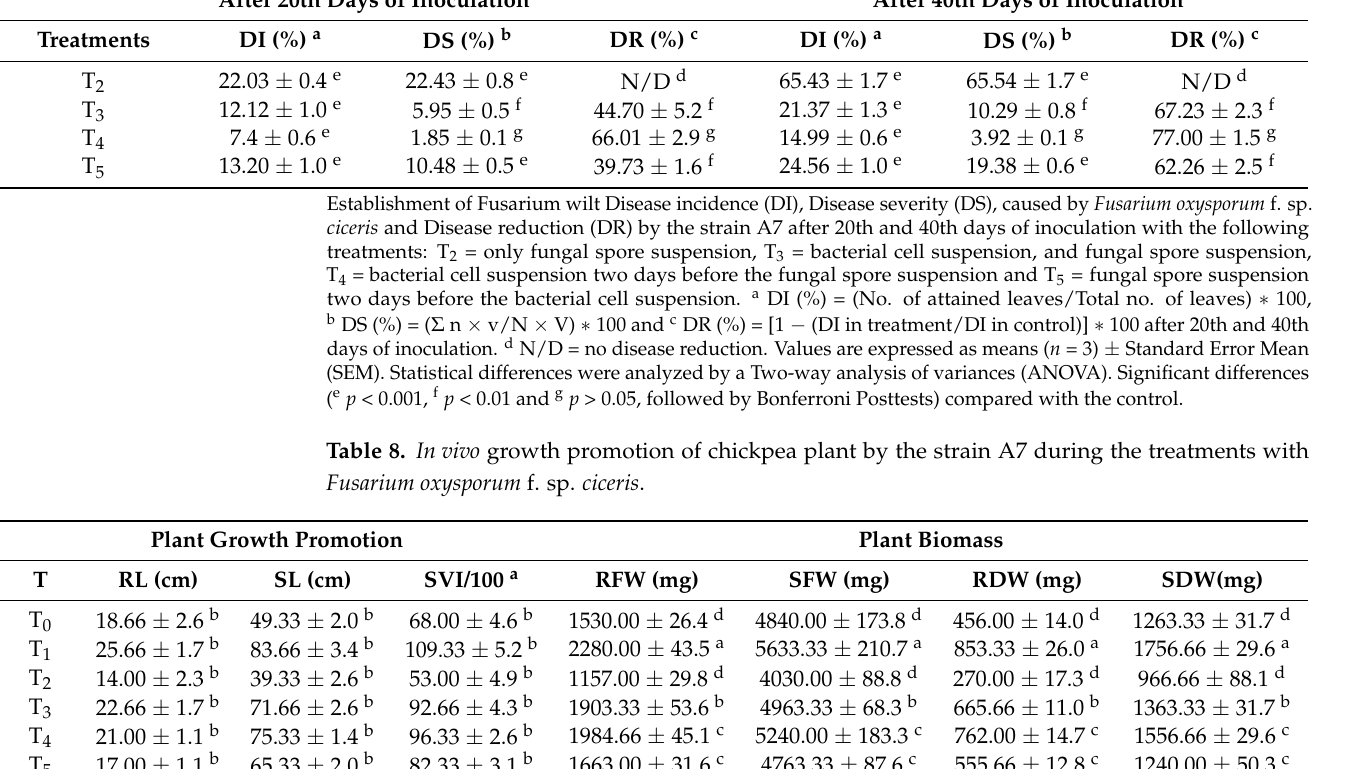
Table 7. In vivo disease incidence, severity, and reduction of Fusarium wilt of chickpea by A7. After 20th Days of Inoculation After 40th Days of Inoculation Treatments